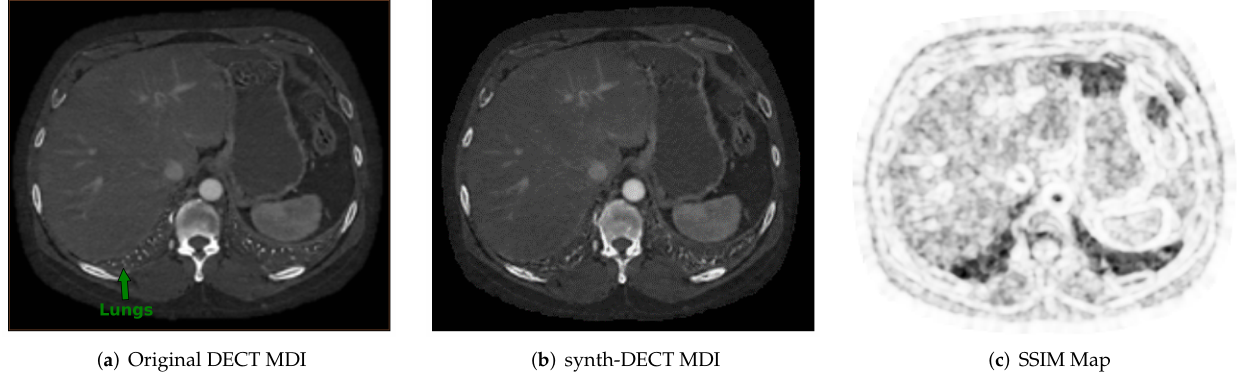
Figure 3. Example cross sectional axial slices from the test dataset used for Pix2Pix. ( a ) The original dual energy CT material density iodine (DECT MDI). ( b ) The synth-DECT MDI for the slice shown in ( a ). The global structural similarity index (SSIM) for the scan from which the slices were taken was computed to be 0.92. ( c ) This figure displays the local SSIM scores for each pixel of the slices in ( a , b ) as an image: The dark areas depict small values of the SSIM, which indicates a large difference between the original and synthetic image. The bright regions show large values of the SSIM or areas that were the most similar between the original and